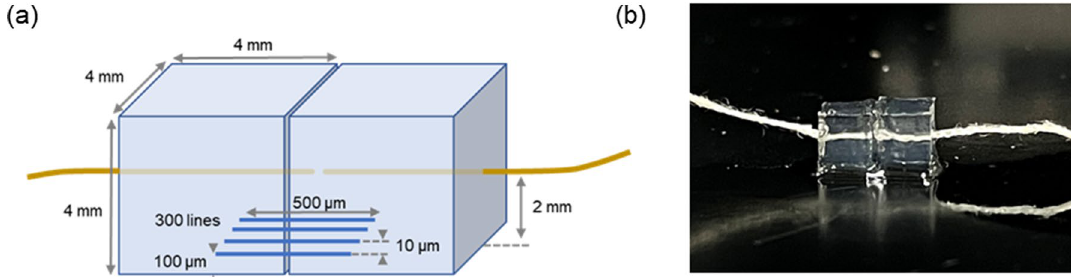
Figure 5. ( a ) Schematic and ( b ) optical photograph of tensile measurement of the CNF/PEGDA composite microstructure with hydrogel blocks. The length of each scan and the distance between scanned lines were 500 µm and 10 µm, respectively. To connect the hydrogel blocks at a height of 100 µm from the bottom surface of the hydrogel, 300-line microstructures were fabricated. The laser power and the scanning speed were 18 mW and 50 µm/s, respectively.